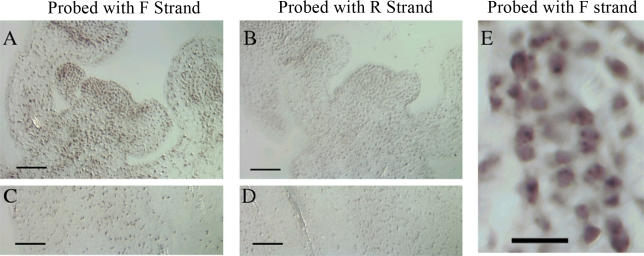
In Situ Hybridization of Centromeric Probes with Longitudinal Sections of Inflorescences(A) Inflorescence meristem and developing buds probed with digoxigenin-labeled F strand of cen180 F + R PCR products and (B) probed with R strand. Mature tissue about 5 mm below the meristem (C) probed with F strand of cen180 and (D) probed with R strand. The scale bars are 50 μm.(E) More highly magnified view of nuclei from developing buds probed with F strand (scale bar is 10 μm).